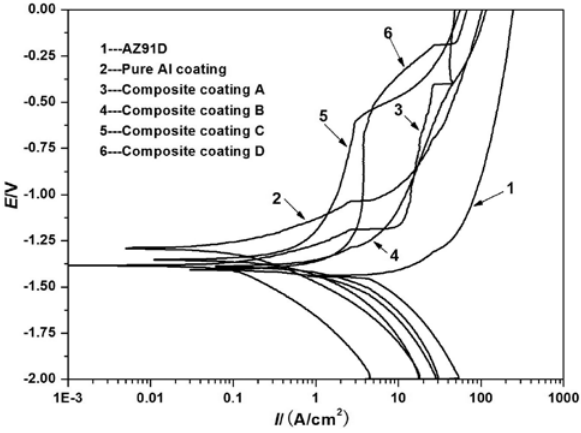
Figure 6 Potentiodynamic polarization curves for AZ91D substrate, pure Al coating, and Al